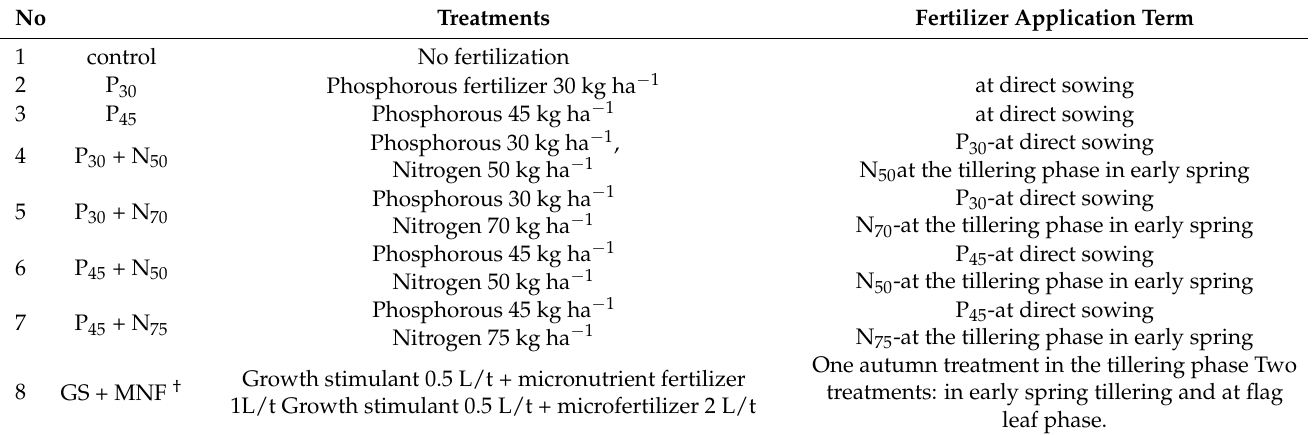
Table 1. Design of the field experiment with direct sowing of winter wheat with various fertilization in South